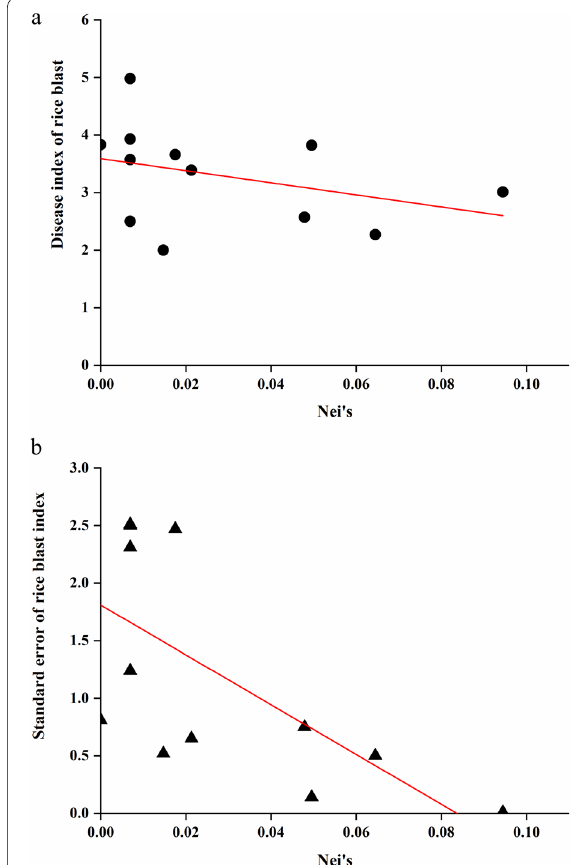
Fig. 3 The correlation between rice blast disease and Nei’s diversity. a The correlation between disease index of rice blast and Nei’s diversity index. b The correlation between standard error of rice blast disease index and Nei’s diversity index. Red straight lines indicate the trend line. Black solid cycles indicate the mean disease index of multi‑genotype varieties (4 varieties: YQ3, YQ5, YQ6, YQ11), component lines (CP‑YQ3: 3‑1, 3‑2, 3‑3, 3‑4, 3‑5; CP‑YQ5: 5‑1, 5‑2, 5‑3, 5‑4, 5‑5, 5‑6, 5‑7; CP‑YQ6: 6‑1, 6‑2, 6‑3, 6‑4, 6‑5; CP‑YQ11: 11‑1, 11‑2, 11‑3, 11‑4, 11‑5) and the control variety YiXiangYou2115 (four replicates, each corresponding to one of the four multi‑genotype varieties). Black solid triangles indicate standard error of disease